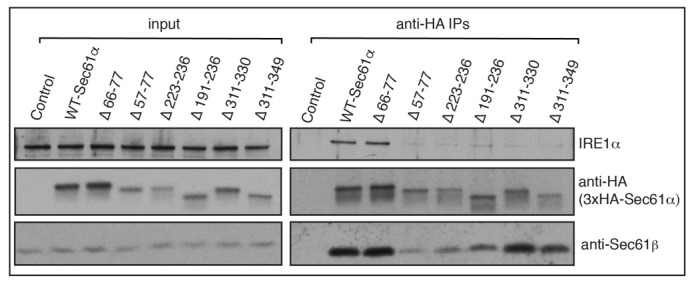
Domain mapping of the IRE1α interaction region in Sec61α.The lysates prepared from HEK293 cells transiently expressing the indicated 3x-HA tagged Sec61a variants were immunoprecipitated with anti-HA antibodies and analyzed by immunoblotting. Δ denotes deletion of indicated amino acid residues from canine Sec61a.